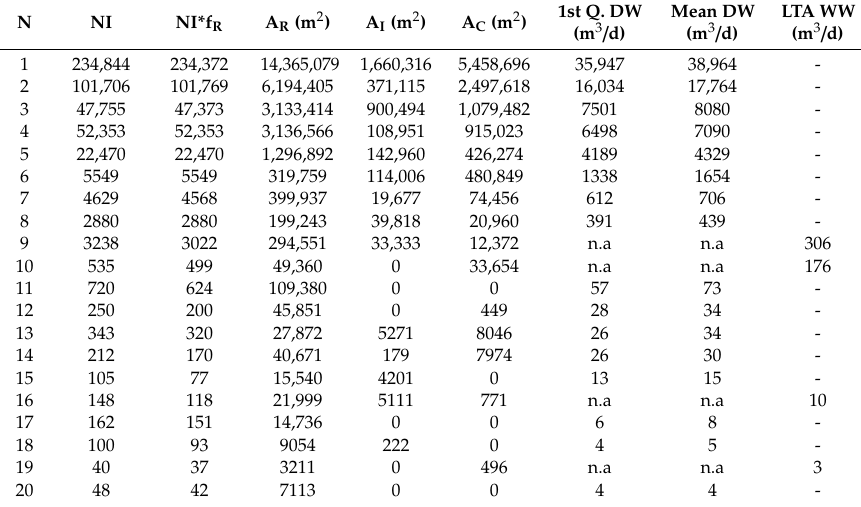
Table A1. NI = Number of inhabitants in the catchment; NI*f R = NI multiplied with rural